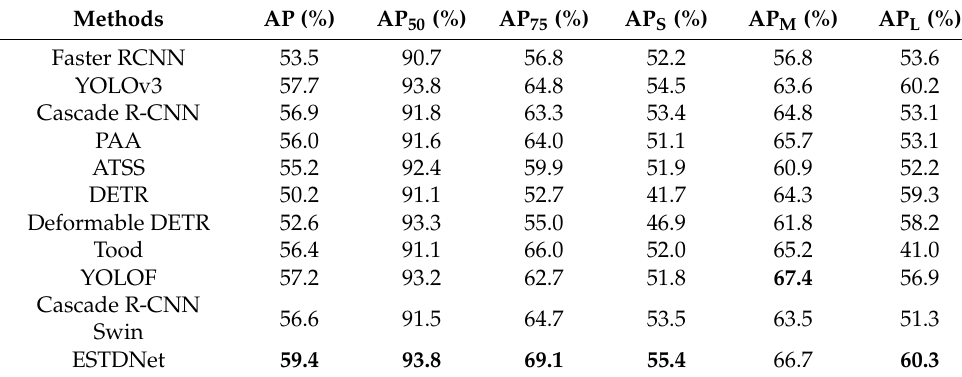
Table 3. The results of different methods on the SSDD